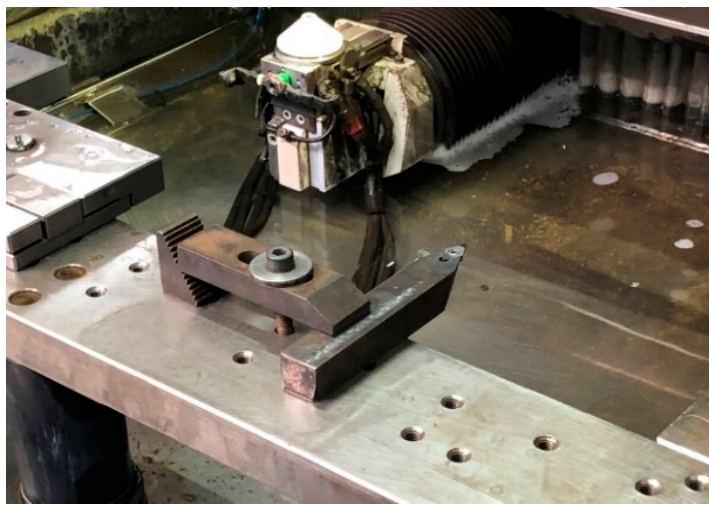
Figure 7. Sharpening of the cutting insert with EDM machining on Fanuc 31/WA.